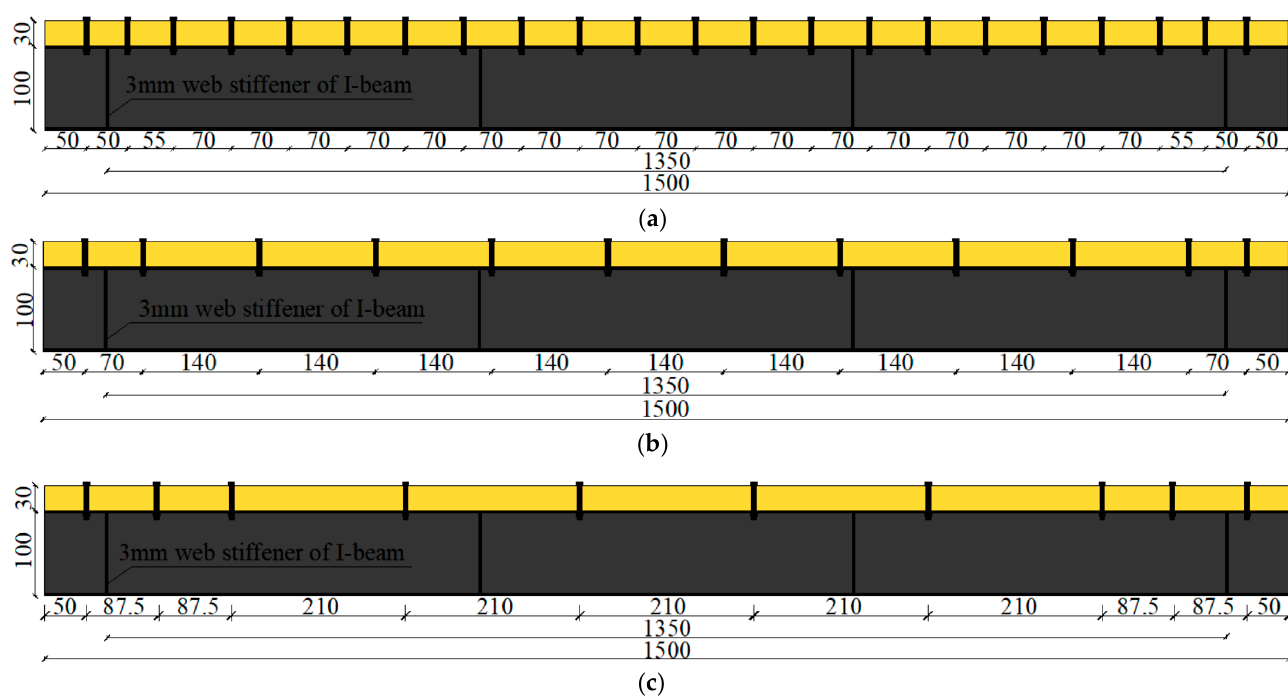
Figure 2. Vertical structural layout of each test specimen (unit: mm): ( a ) Elevation of test specimens (L2-3, L2-4, L3-1, L3-2, and L4-1) with longitudinal distance of 70 mm; ( b ) Elevation of test specimen (L2-2 and L4-2) with longitudinal distance of 140 mm; ( c ) Elevation of test specimen (L1-1 and L2-1) with longitudinal distance of 210 mm.